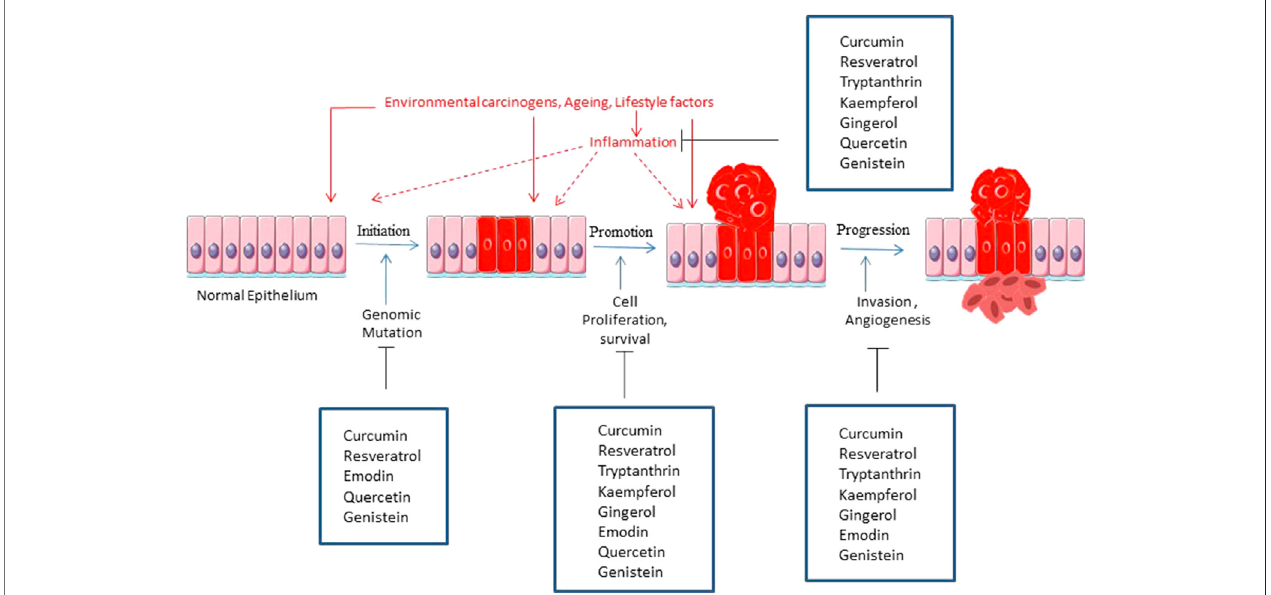
FIGURE 4 | Illustration of various steps of carcinogenesis inhibited by the phytochemicals.